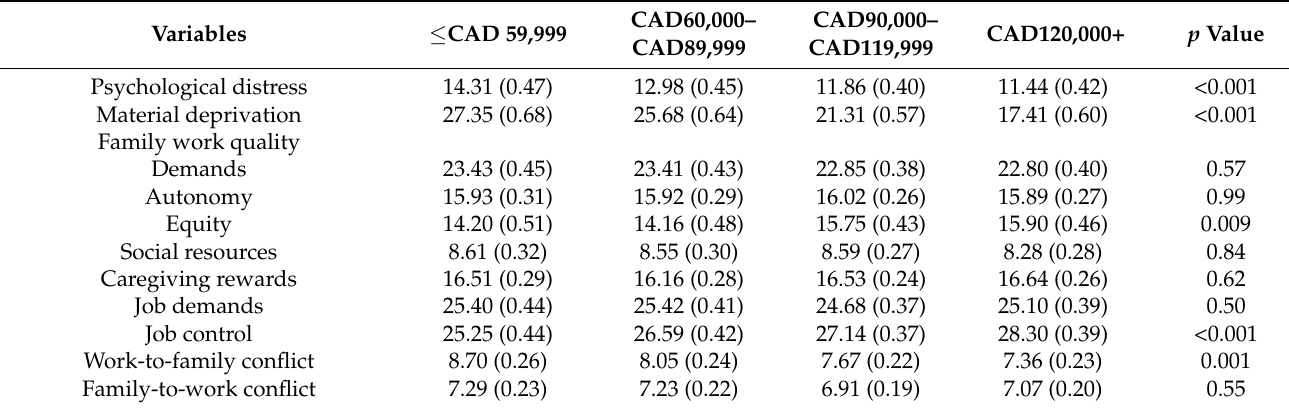
Table 3. The association of household income with psychological distress, material deprivation, and psychosocial qualities (means with standard errors in parentheses) ( n = 512) 1